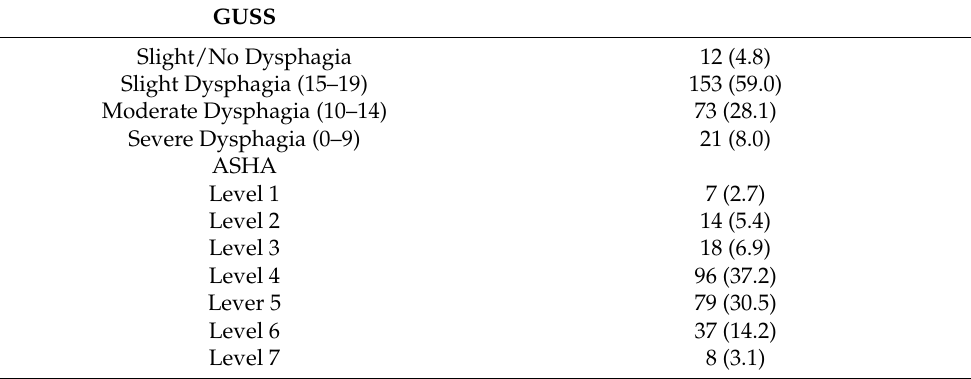
Table 2. Dysphagia assessment; GUSS and ASHA absolute and relative frequencies (%).